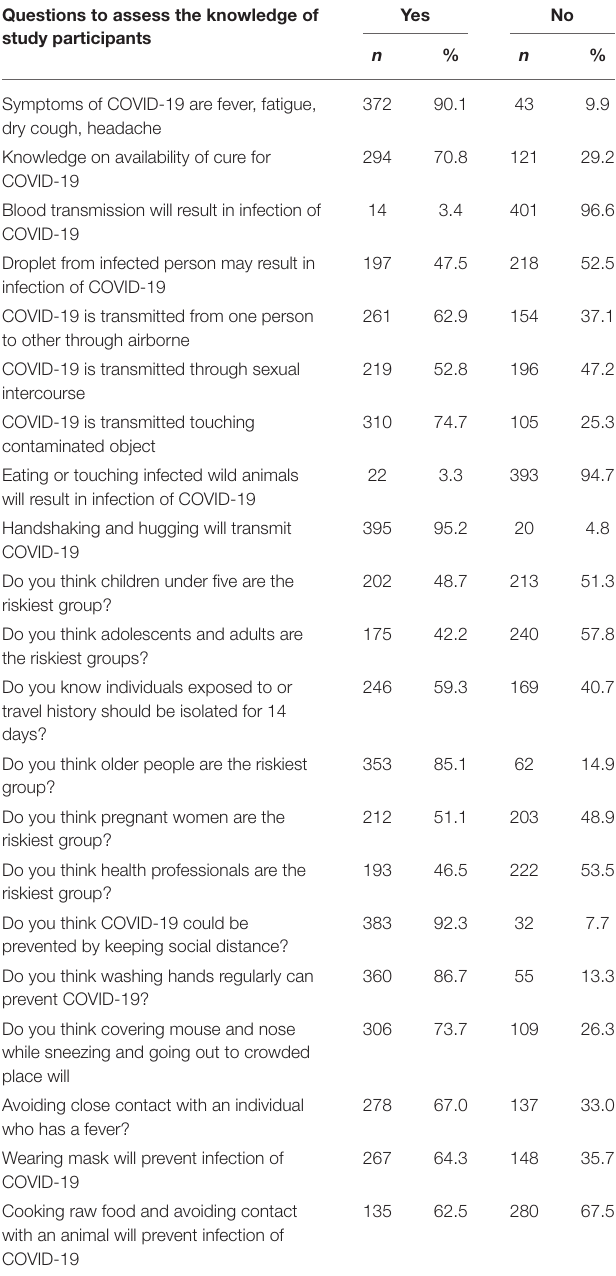
TABLE 3 | Frequency of respondent’s attitudes on coronavirus, Dire Dawa administration, Eastern Ethiopia, May, 2020 ( N = 415). Attitudes question Very high (very